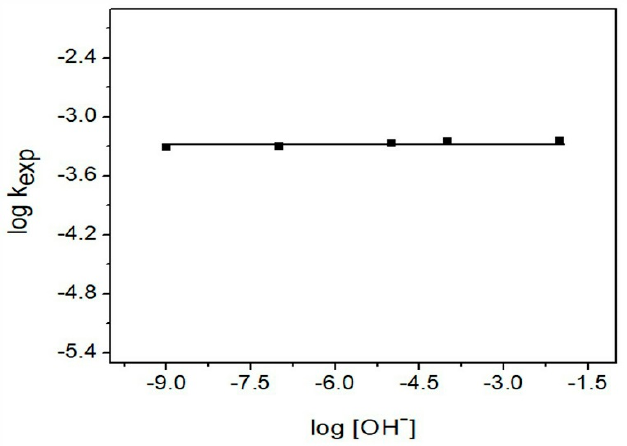
Figure 11. Dependence of log k exp in function of log [OH − ], obtained reaction order n = 0 (V = 0.5 L, 40 g ∙ L − 1 Mineral, PO 2 = 1 atm, leaching time = 240 min, [S 2 O 32 − ] = 0.16 mol ∙ L − 1 , [Cu 2+ ] = 0.006 mol ∙ L − 1 , 298 K (25 °C), RPM = 750 min − 1 ).